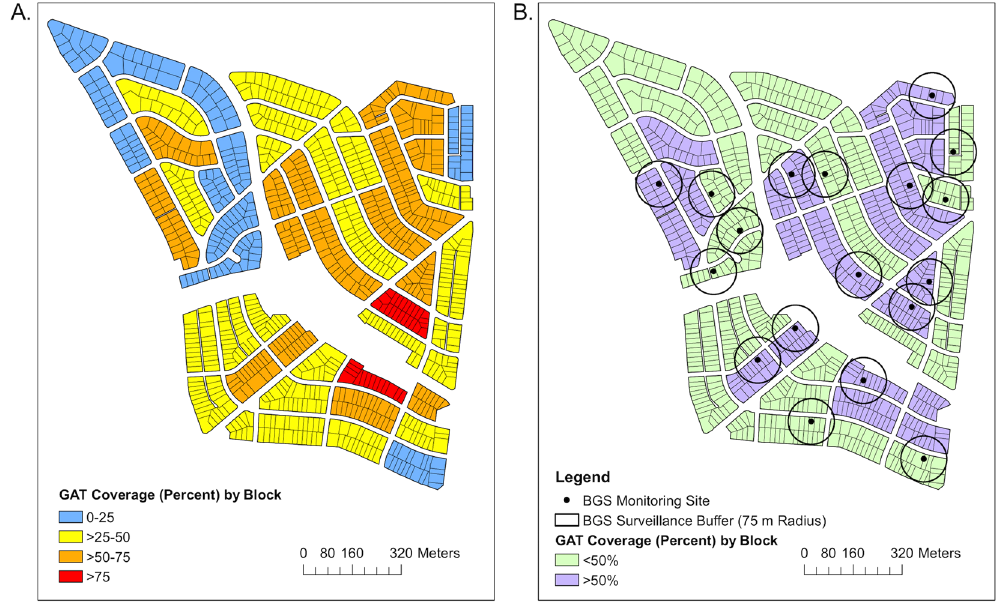
Figure 1. ( A ) Individual Gravid Aedes Trap (GAT) coverages (percentage of yards with traps) for all blocks in University Park, MD and ( B ) selected high ( > 50%) and low ( < 50%) coverage adult Ae. albopictus surveillance blocks. Participating households purchased 2 GAT traps; one for the front yard and one for the backyard. BGS refers to the BioGents Sentinel trap used to monitor host-seeking female abundance for research results 29 . To protect the privacy of the residents the specific locations of the yards with GATs are not visualized but de- identified data are available upon request.